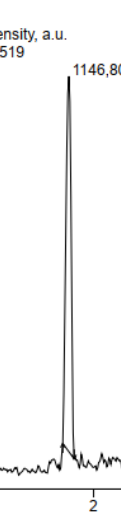
Figure 7. SIM (selected ion monitoring) chromatograms of the antimicrobial compounds from the fengycin family putatively identified in the supernatant of B. velezensis IP22 cultivation broth.